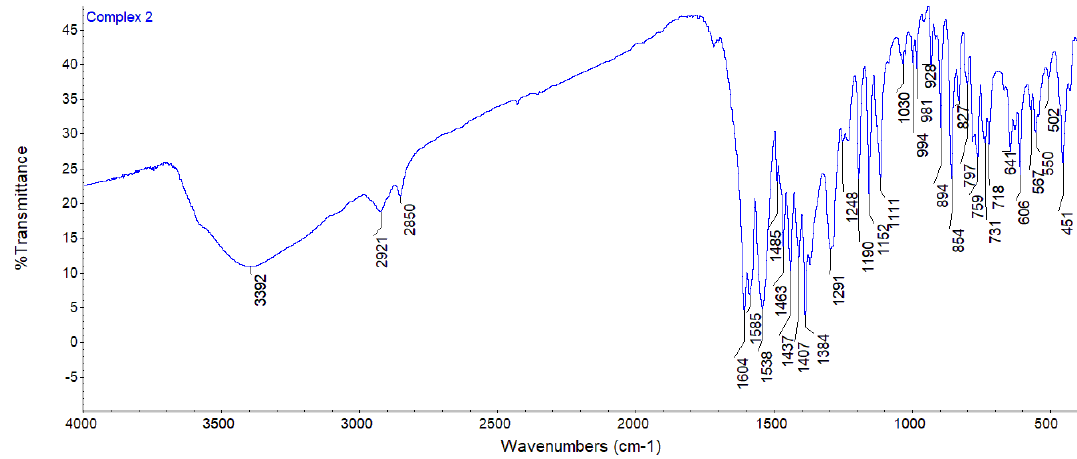
Figure 5. FT-IR spectrum of complex 2 · 2H 2 O.